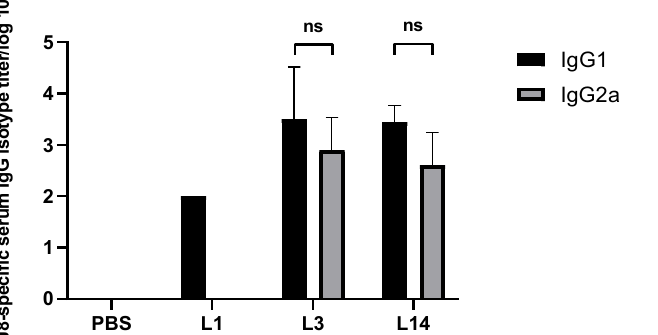
Figure 4. J8-specific IgG subclasses (log 10) at day 52 post primary immunization. Statistical analysis was performed using one-way ANOVA followed by Tukey’s post hoc test to compare with PBS-administered mice (ns, p > 0.05). Statistical analyses were performed using GraphPad Prism version 8.03.